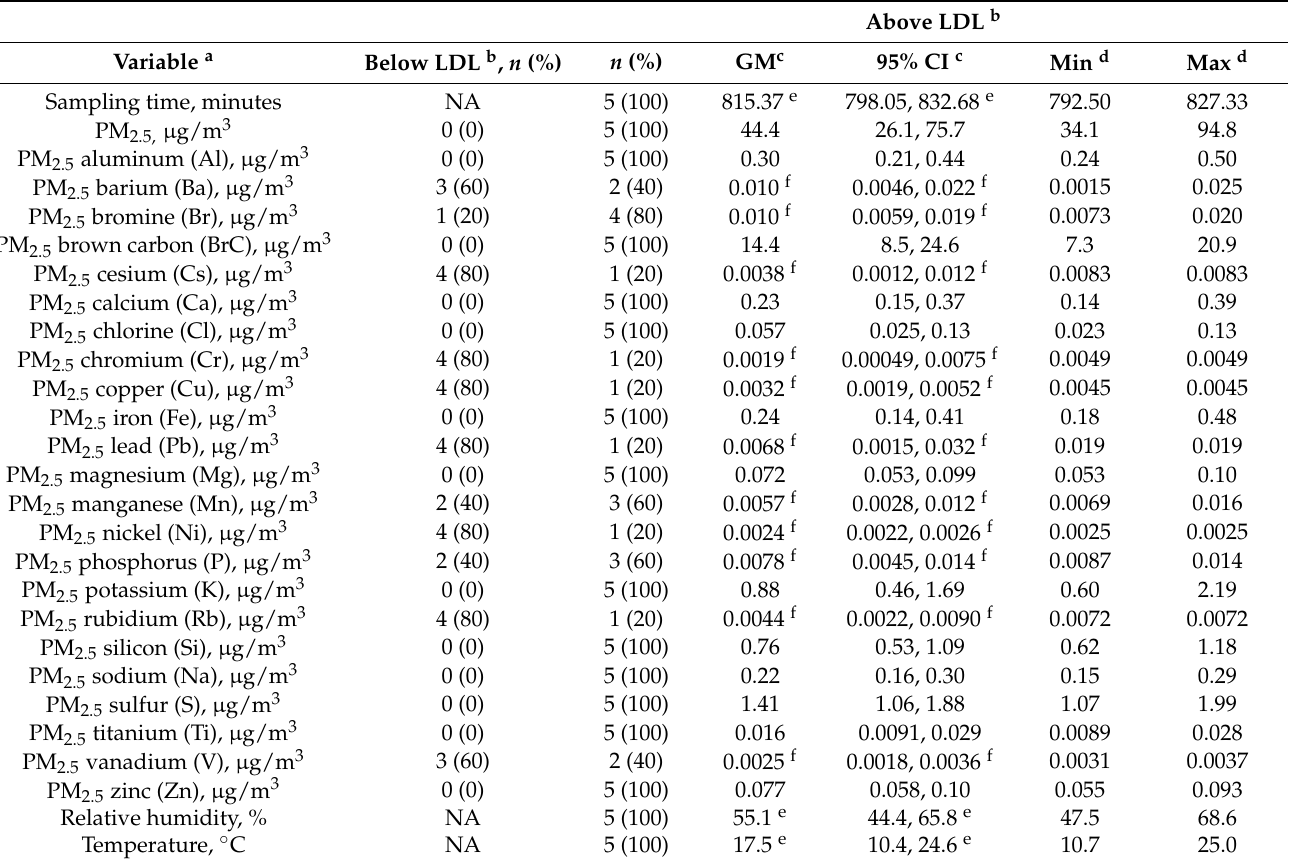
Table 1. Summary statistics for the mean (of the sampling period) of samples inside or outside teahouses in villages along the Poon Hill circuit trek, Nepal, May